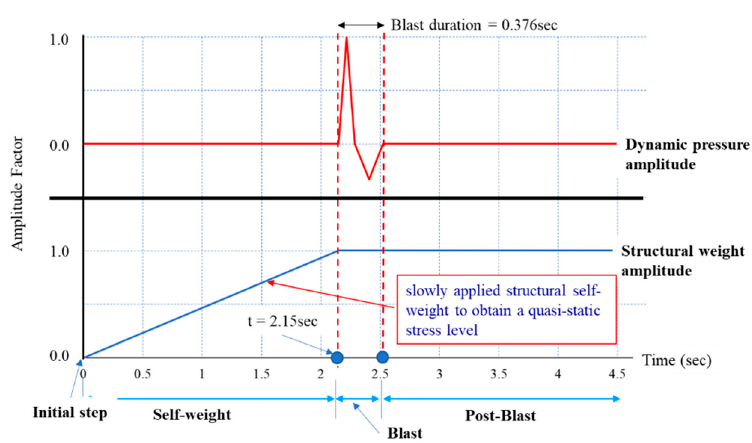
Figure 11. Vertical reaction force for instantaneously applied self-weight.